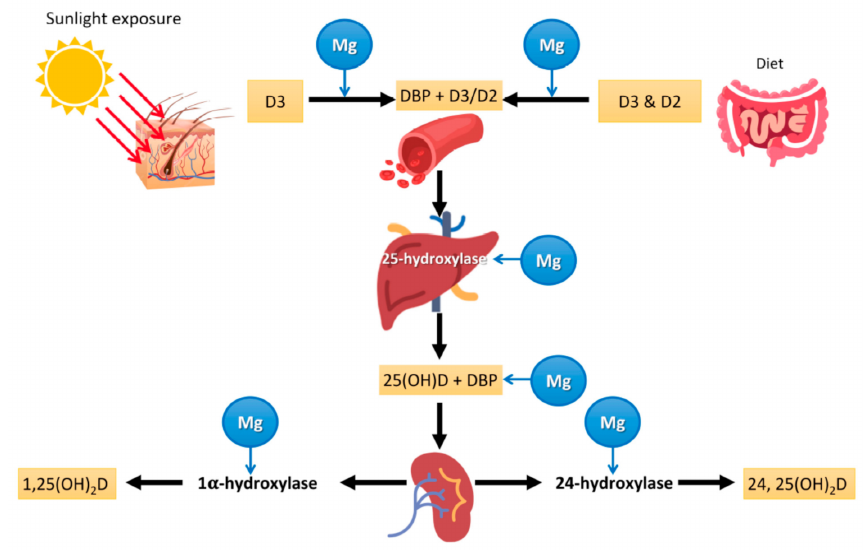
Figure 1. Mg and vitamin D metabolism. Vitamin D3 is produced in the skin through the action of UVB radiation reaching 7-dehydrocholesterol in the skin, followed by a thermal reaction. That vitamin D3 or oral vitamin D (D2 (ergocholecalciferol) or D3 (cholecalciferol) are converted to 25(OH)D in the liver and then to the active hormonal metabolite 1,25(OH) 2 D (calcitriol) in the kidneys or other organs as needed. As shown in the graph, Mg is a cofactor that is required for the binding of vitamin D to its transport protein, for the conversion of vitamin D by hepatic 25-hydroxlation, for the transport of 25(OH)D, and for renal 1 α -hydroxylation into the active hormonal form. Therefore, all these steps are Mg-dependent. DBP: vitamin D-binding